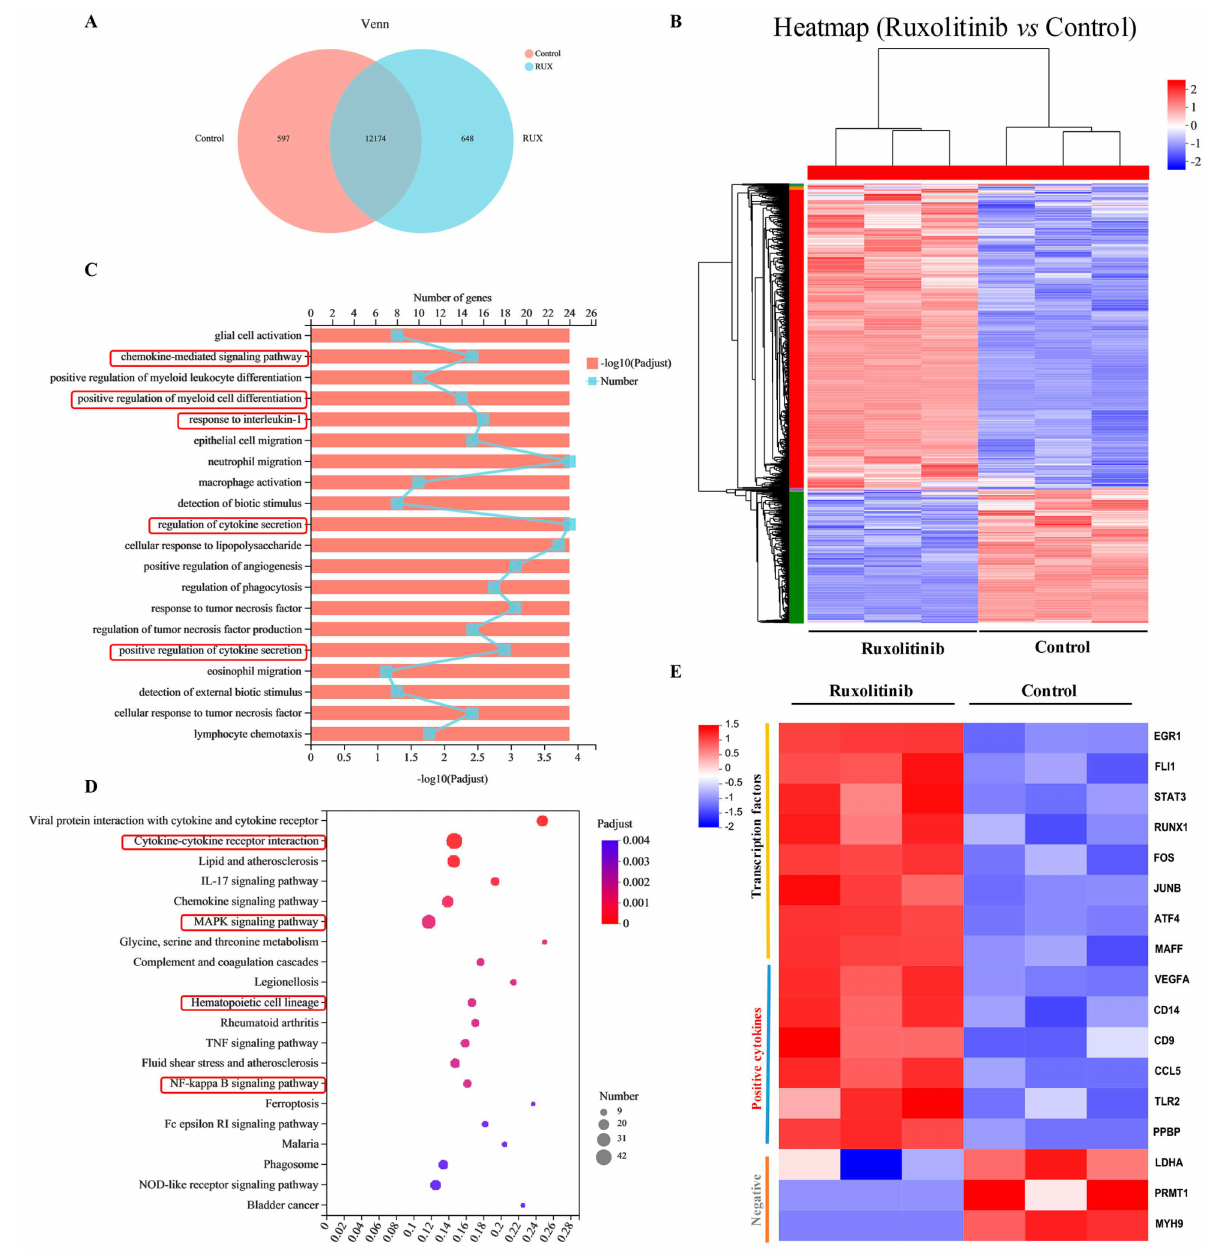
Figure 7. Bioinformatics analysis of gene expression profiles. ( A ) Venn diagram of the identified DEGs; ( B ) Hierarchical clustering analysis of DEGs regulated by ruxolitinib; ( C ) GO enrichment analysis of the identified DEGs; ( D ) KEGG pathway enrichment analysis of the identified DEGs; ( E ) Cluster analysis of DEGs associated with ruxolitinib regulated MK differentiation and platelet